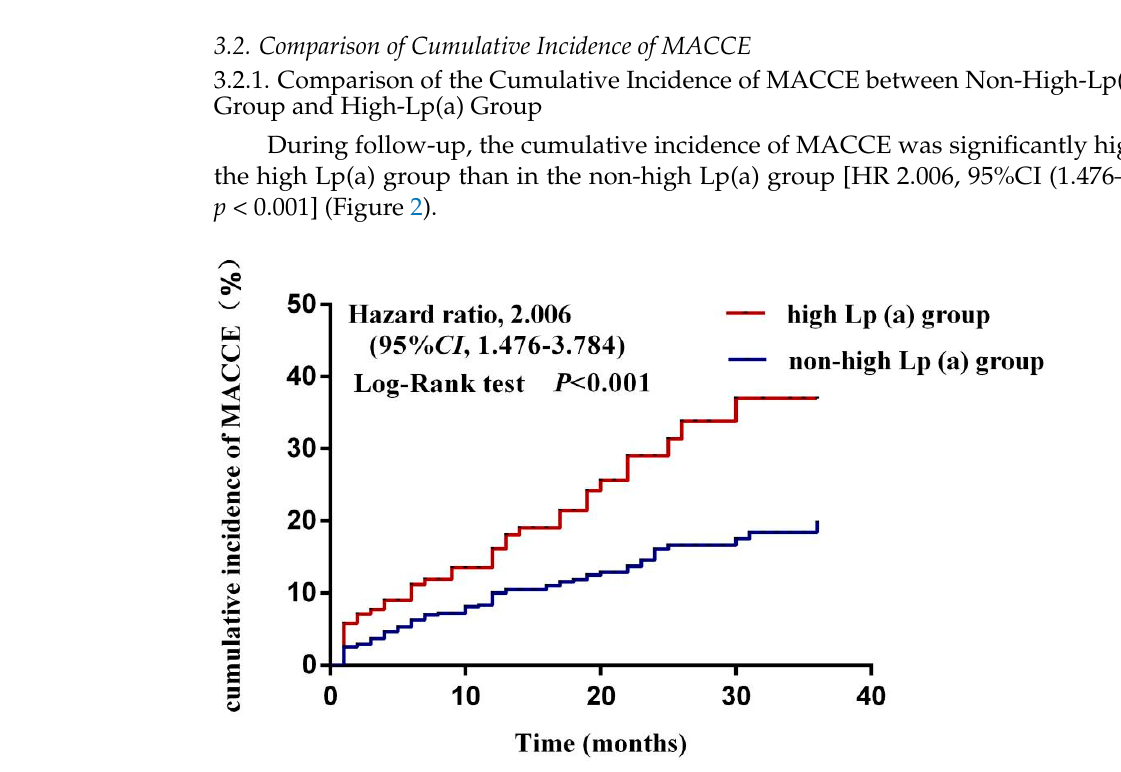
Figure 2. Comparison of the cumulative incidence of MACCE between high-Lp(a) group and non-high-Lp(a) group.